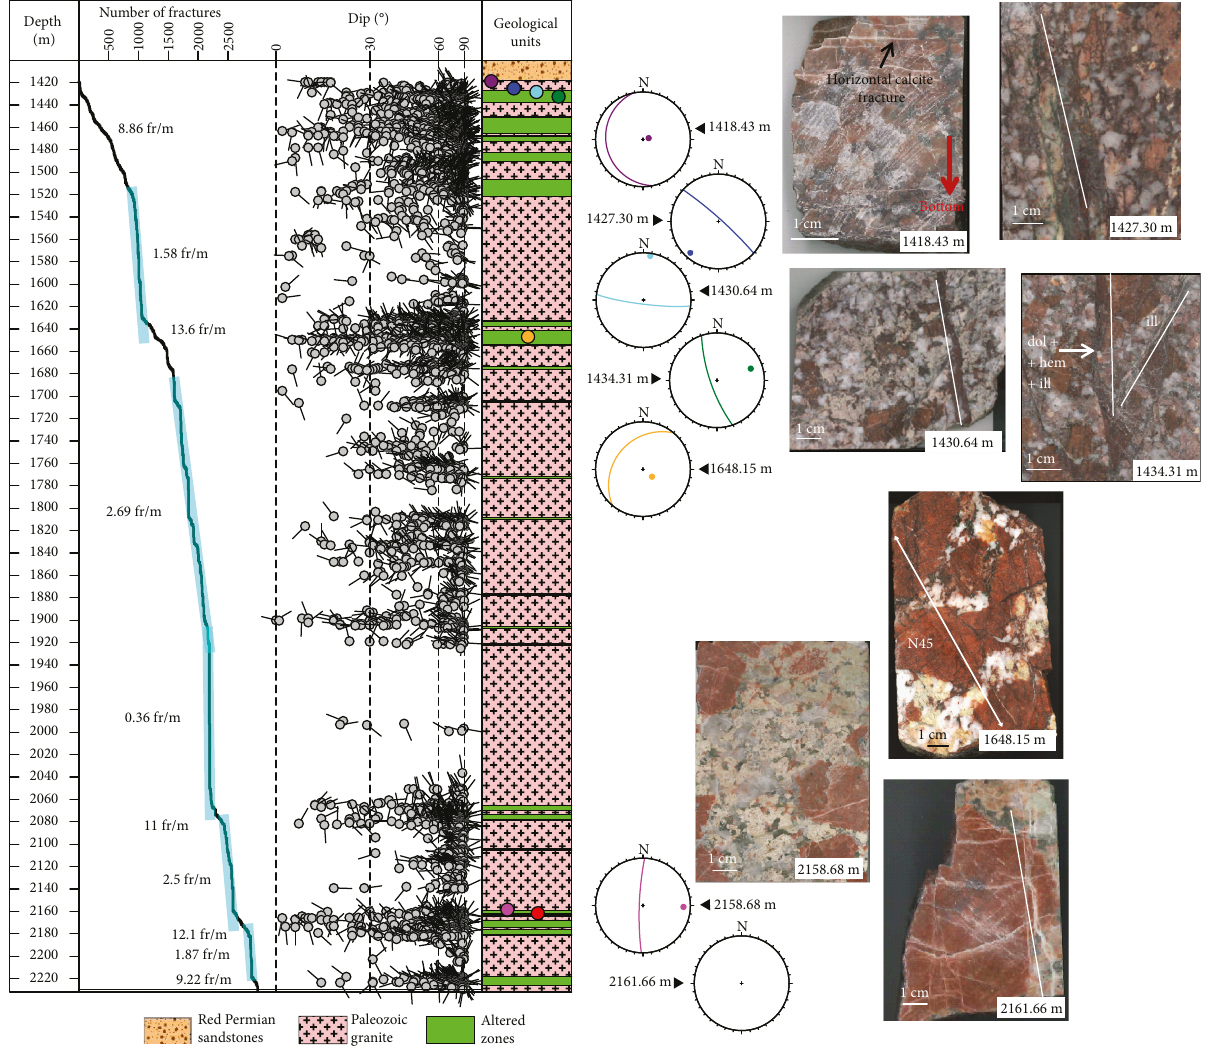
Figure 7: Composite log of Hercynian granite in the EPS1 well. The fi rst column represents the measured depth; the second, the cumulative fracture log; the third, the fracture orientation; the fourth, the geological units [60]. The location and macroscopic pictures of samples are shown. The orientation (great circle and pole) of sampled fractures is represented in Schmidt ’ s projection, lower